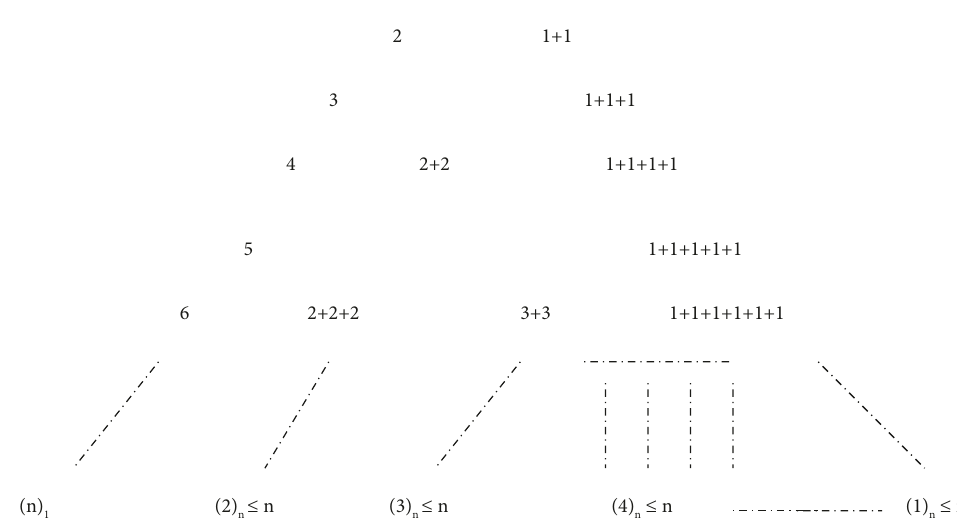
Figure 3: Position of vertices of degree one in Figure